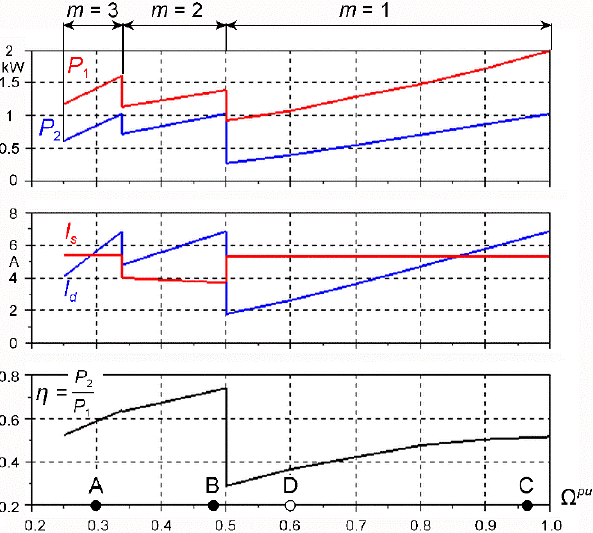
Figure 13. Steady-state characteristics for various values of speed with a constant output voltage u d = U dN = 150 V held by the control system: P 1 = T m Ω — input power, P 2 = U d I d — output power, I s — rms stator current, I d — mean output current, η — system efficiency, A,B,C,D – distinguished operation cases.